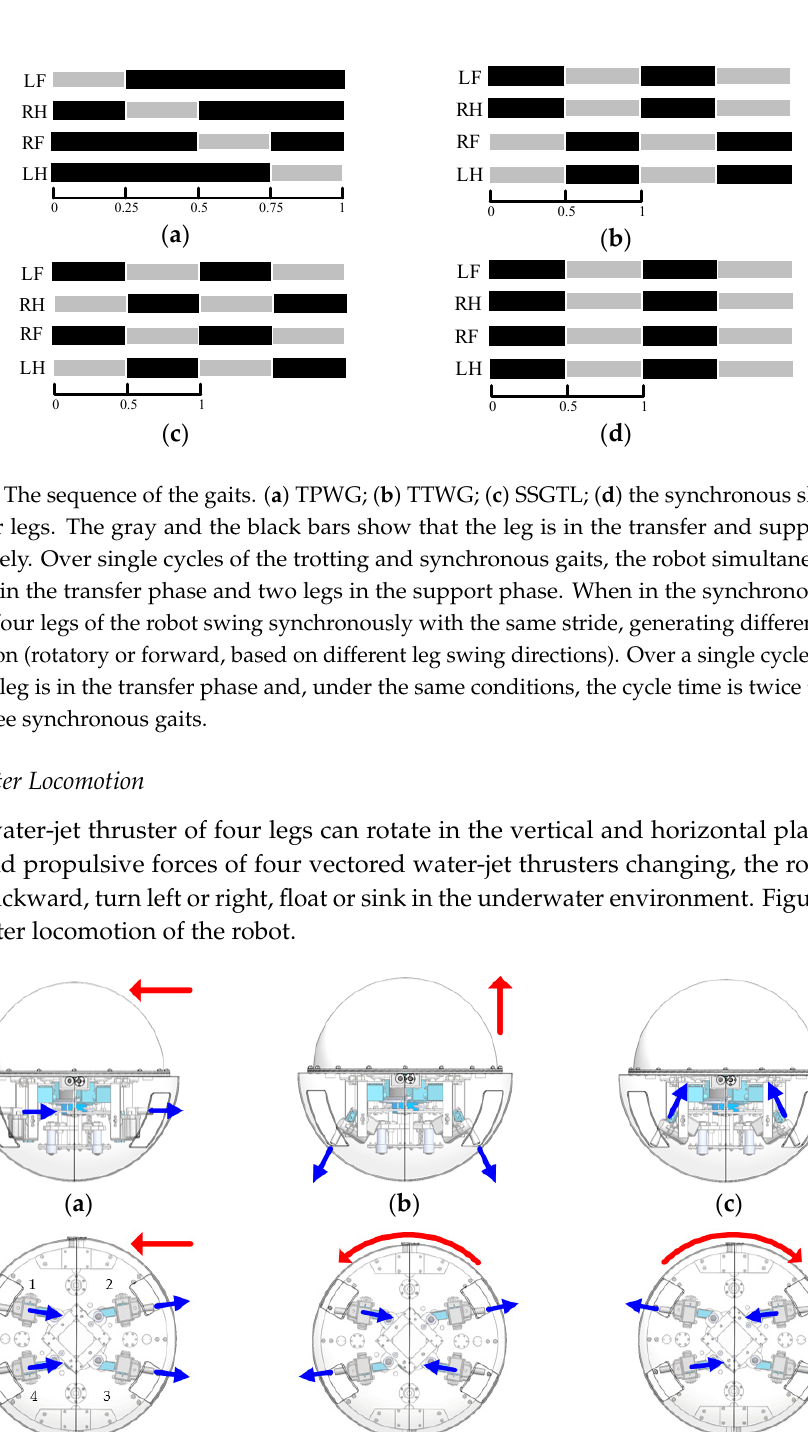
( e ) Figure 6. Turtle gaits (The black arrow indicates that the leg is in transfer phase). ( a ) The tripod walking gait (TPWG); ( b ) the trotting walking gait (TTWG); ( c ) the synchronous sliding gait with two legs (SSGTL); ( d ) the synchronous sliding gait with four legs; ( e ) the rotary sliding gait with zero radius. RFLF RH